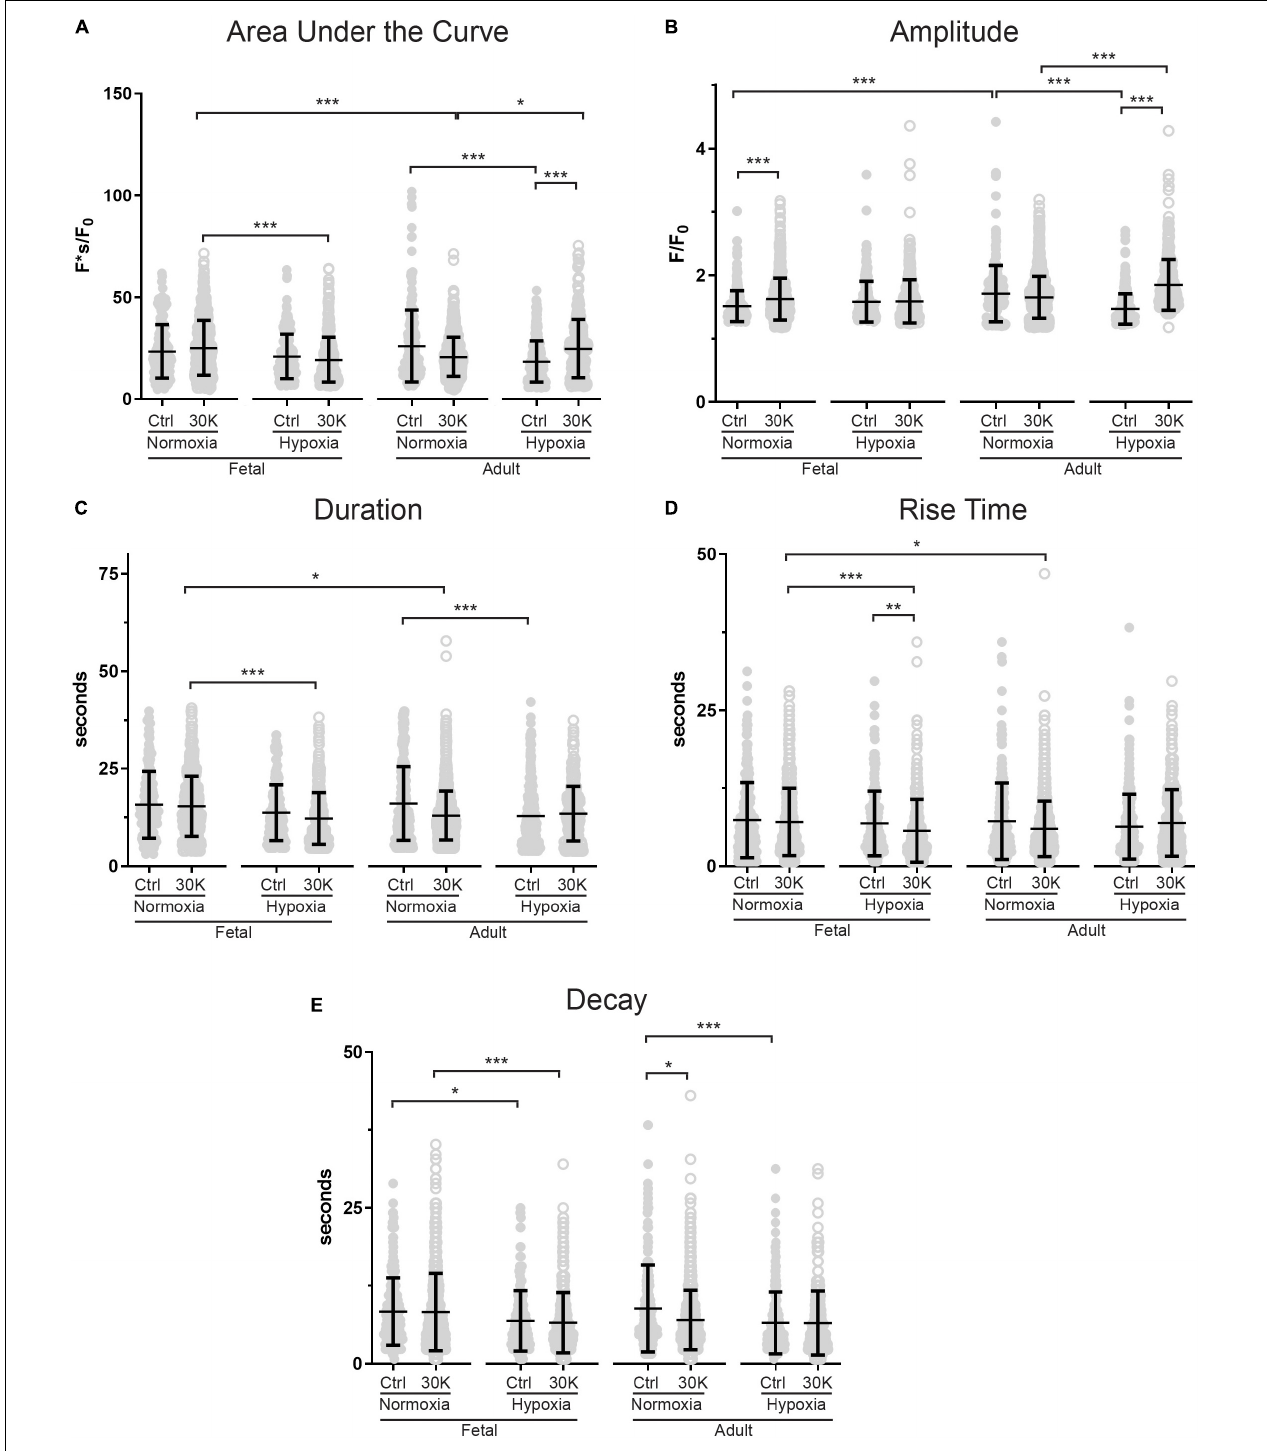
FIGURE 4 | Long-term hypoxia has minimal effect on the magnitude or temporal aspects of medium duration Ca 2 + oscillations in fetal and adult sheep. Effects of membrane depolarization with 30 mM K, long-term hypoxia, and animal age on (A) area under the curve, (B) amplitude of the fractional fluorescence, (C) duration of the event, (D) rise time, and (E) decay time in cytosolic fractional fluorescence. Bars represent mean ± SD for each parameter; closed circles specify control conditions, and open circles treatment with 30K. * P < 0.05, ** P < 0.01, *** P < 0.001 indicate significance based on a Kruskal–Wallis ANOVA with a Dunn’s multiple comparisons test based on ranks. Control recordings were made in 207/3 FN, 201/4 FH, 225/3 AN, and 325/4 AH ROIs and animals, respectively. 30K recordings were made in 642/3 FN, 394/4 FH, 1204/3 AN, and 312/4 AH ROIs and animals, respectively.